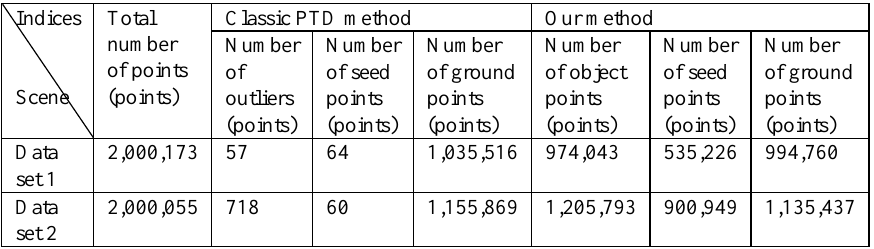
Table 2. Statistics about the filtered results of the two filters